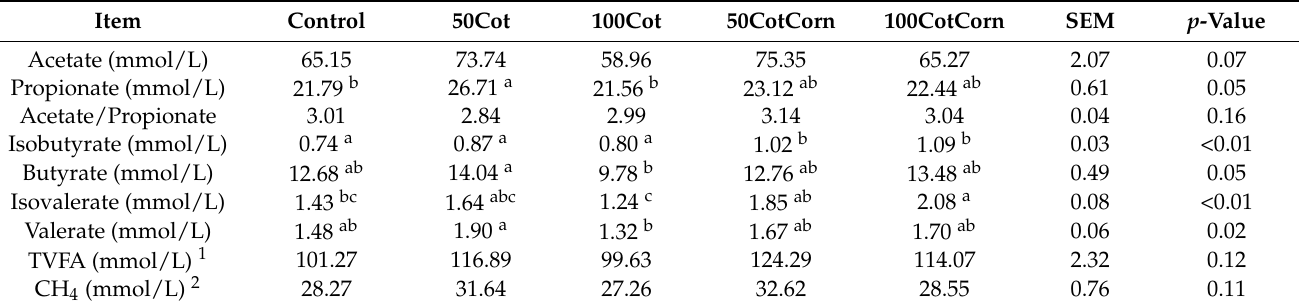
Table 6. Rumen fermentation parameters in rumen fluid of dairy cows fed diets containing mildewy corn meal and